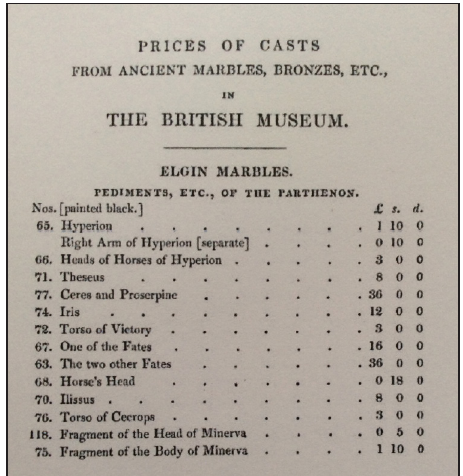
Figure 2: Price list of casts featured in the endpapers of the 1840 edition of the Synopsis of the Contents of the British Museum (Courtesy of ( Fig. 2 ). By this point, other reproductions such as fictile ivory (plaster casts of ivory